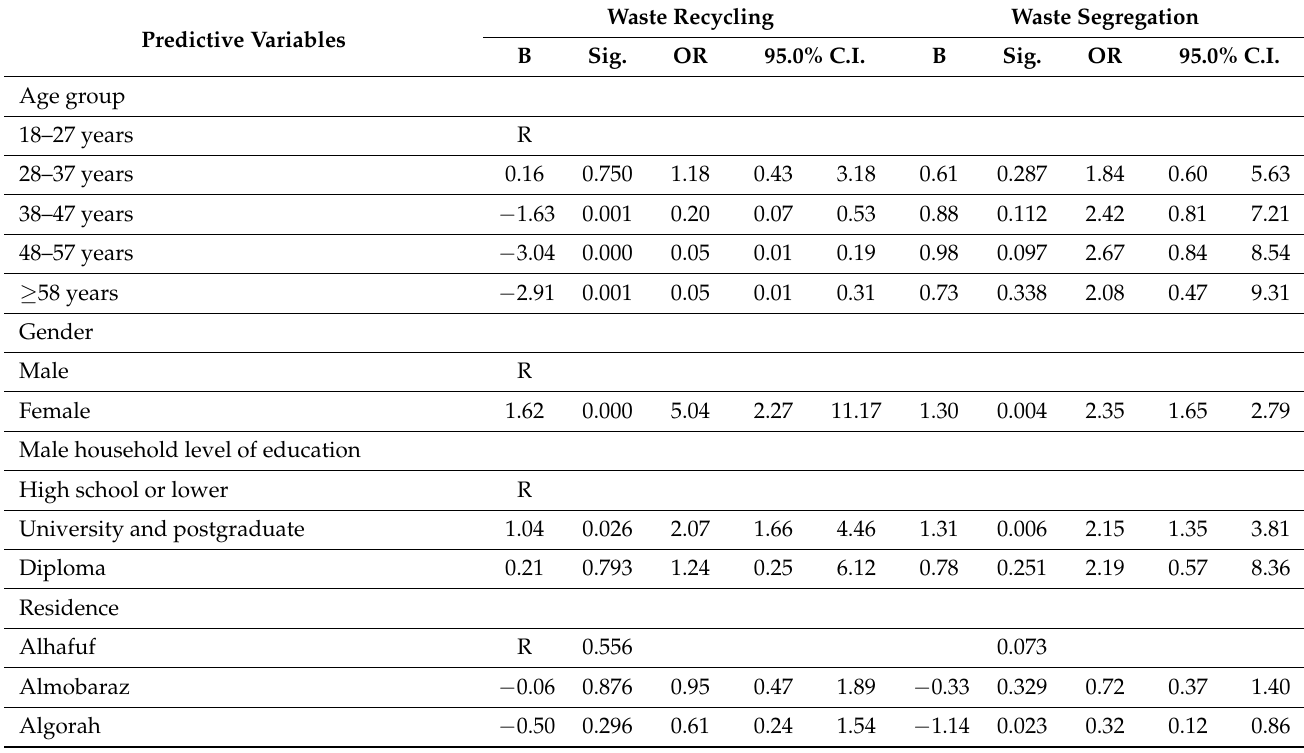
Table 5. Logistic regression for socio-demographic characteristics of the household. Predictors of practicing waste segregation and recycling at source adjusted by level of